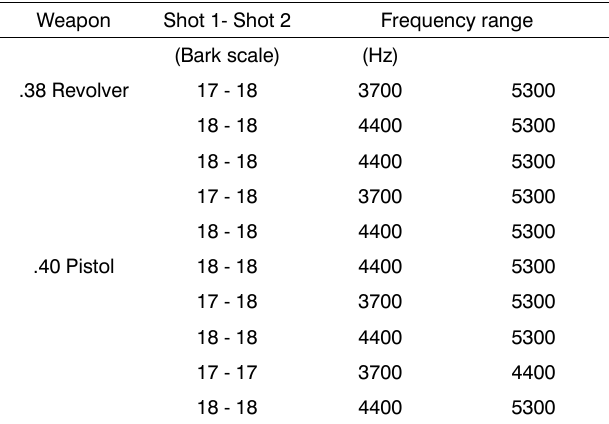
Table 2. Frequency range obtained from the base membrane excitation pattern in the Bark scale for the 10 samples of sounds from the weapons (in two sequences of shots) analyzed by the positional cochleograph and the excitation graph.